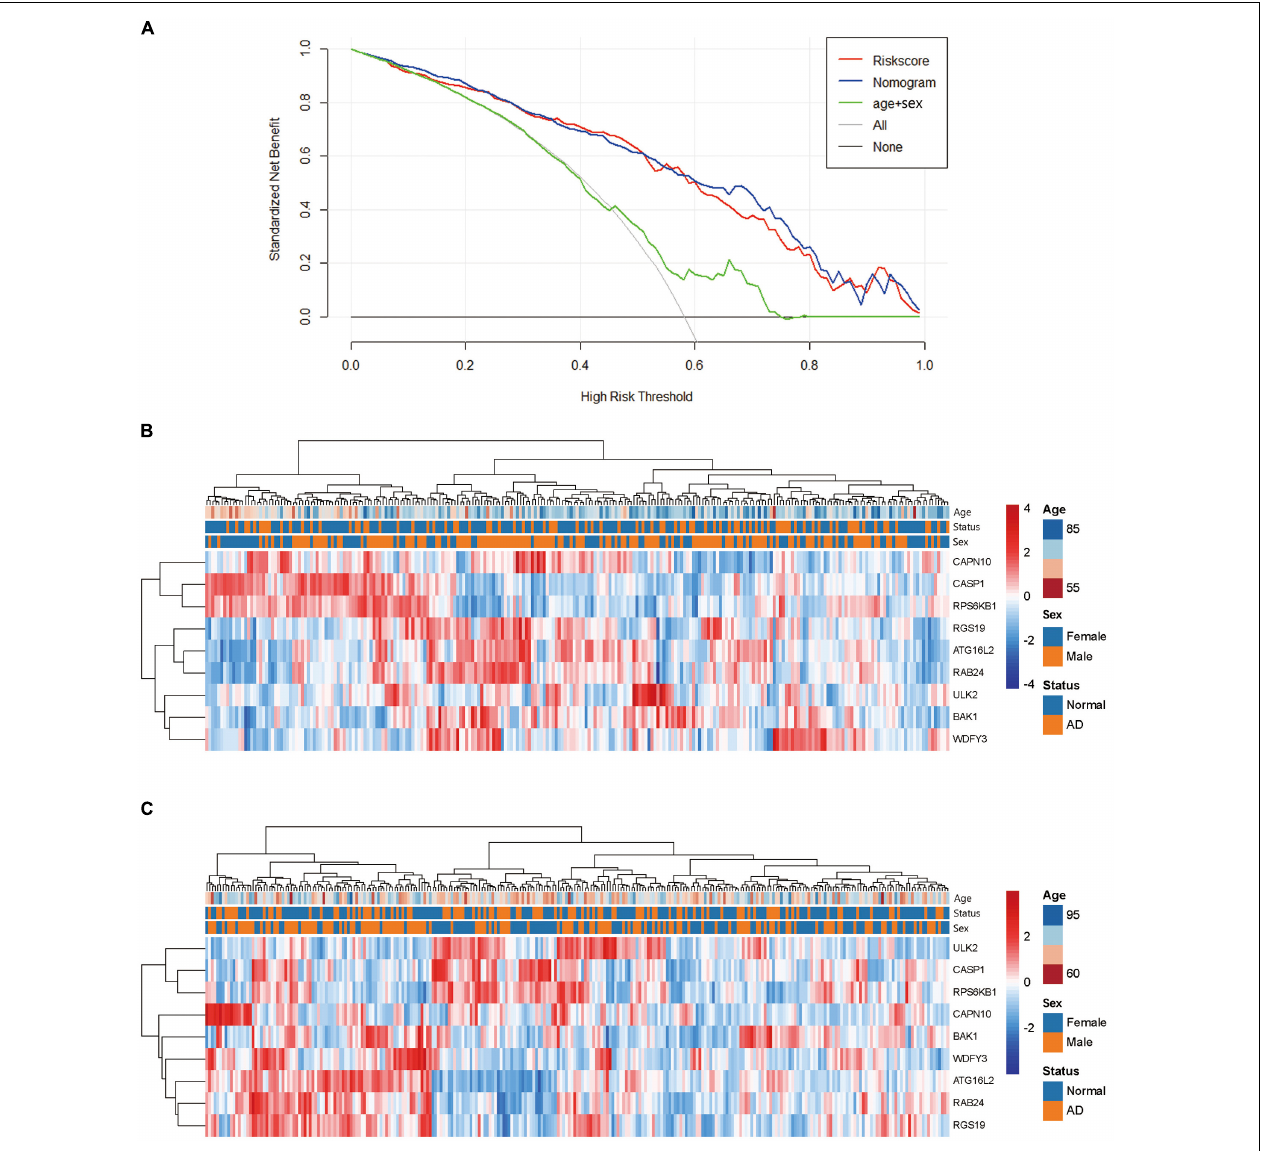
FIGURE 5 | Analysis of the net clinical benefit of the model and the expression patterns of DE-ATGs. (A) Decision curve analysis of the predictive nomogram. DCA for the risk score and the model supplemented with clinical parameters. The y -axis measures the net benefit. The x -axis is the risk threshold probability that changes from 0 to 1. The red line represents the risk score. The blue line represents the nomogram. The green line represents age + sex. The gray line represents the assumption that all patients have thresholds (4–100%), at which using the nomogram to diagnose adds more benefit than the treat-all-patients scheme or the treat-none scheme. (B) Heatmap of the DE-ATGs for the prognostic signature in the GSE63060 set. (C) Heatmap of the DE-ATGs for the prognostic signature in the GSE63061 set. Expression of the nine selected DE-ATGs in AD patients and normal people. Red represents upregulation. Blue represents